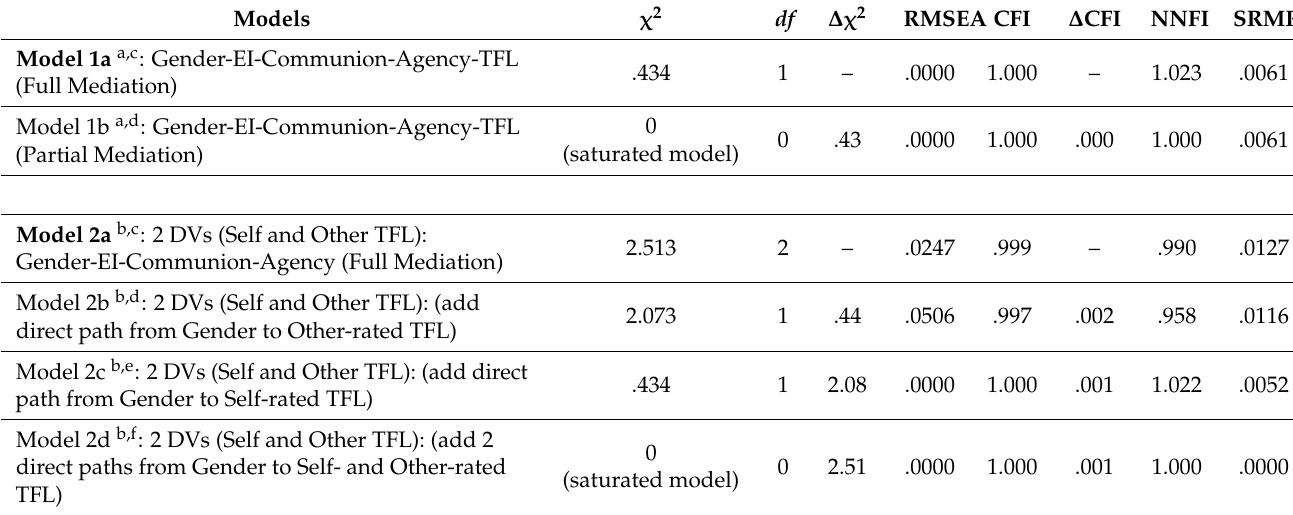
Table 6. Fit statistics for alternative theoretical models.